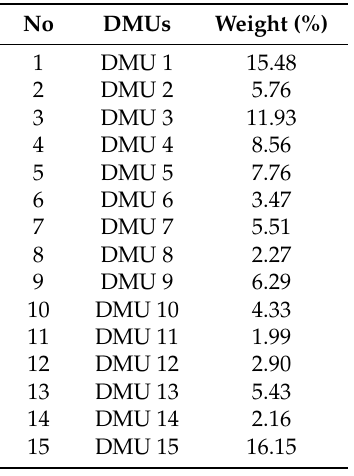
Table 12. The weight of 15 solar panel suppliers.